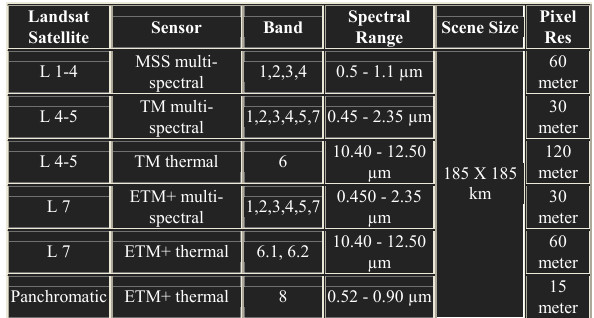
Table 1. Main characteristics for Landsat satellite imagery.